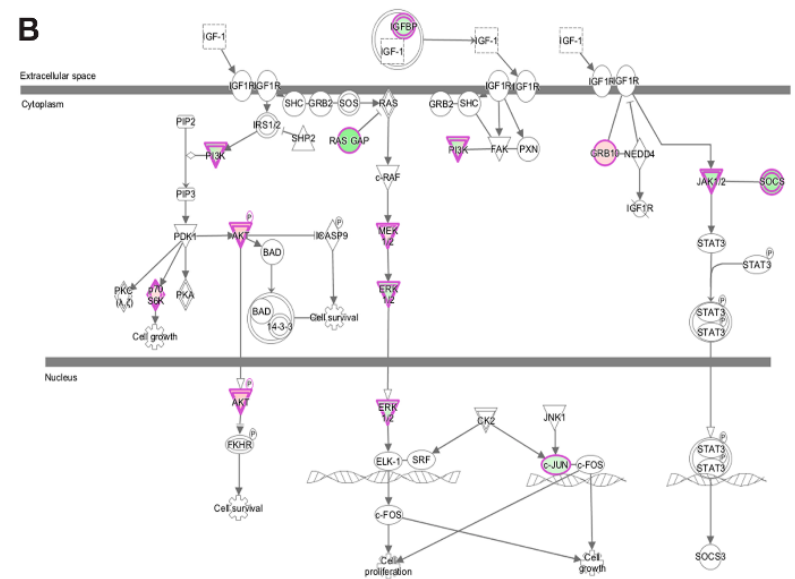
Figure 8. Ingenuity pathway analysis of differentially expressed genes unique to emerin-null cells during transition from day 0 to day 1 of differentiation. ( A , B ) IPA identified the VEGF ( A ) and IGF-1 ( B ) signaling pathways as enriched. The network was generated through the use of IPA (Ingenuity Systems, www.ingenuity.com) on normalized mRNA values. Nodes represent molecules in a pathway, while the biological relationship between nodes is represented by a line (edge). Edges are supported by at least one reference in the Ingenuity Knowledge Base. The intensity of color in a node indicates the degree of up- (red) or down- (green) regulation. Nodes are displayed using shapes that represent the functional class of a gene product (Circle = Other, Nested Circle = Group or Complex, Rhombus = Peptidase, Square = Cytokine, Triangle = Kinase, Vertical ellipse = Transmembrane receptor). Edges are marked with symbols to represent the relationship between nodes (Line only = Binding only, Flat line = inhibits, Solid arrow = Acts on, Solid arrow with flat line = inhibits and acts on, Open circle = leads to, Open arrow = translocates to).